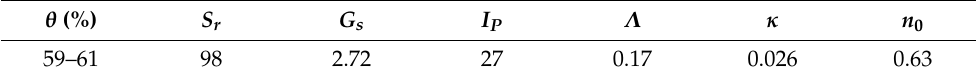
Table 1. Physical parameters of kaolin clay obtained from the test of Wang et al. (2017). θ (%) S r G s I P